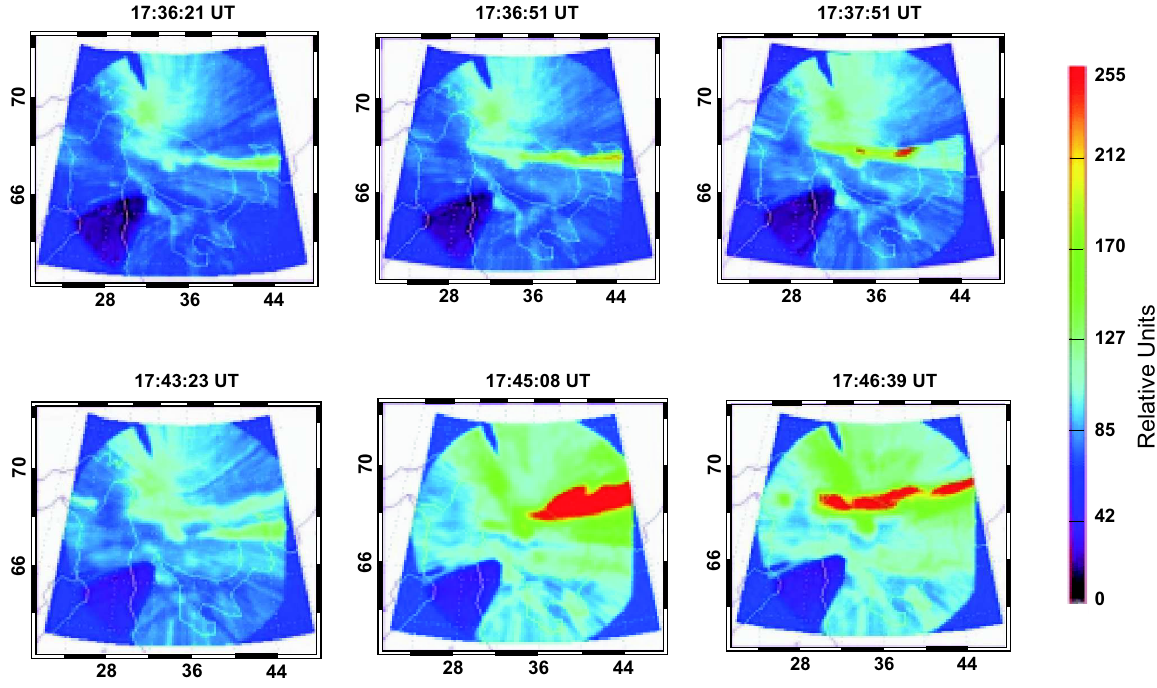
Fig. 9. Sequence of selected TV frames, obtained by the all-sky TV camera situated in Lovozero. The field of view of the TV camera is shown in Fig. 6 by a circle. The auroral dynamics for time before 18:00 UT shows that the maximum of aurora activation is eastward of